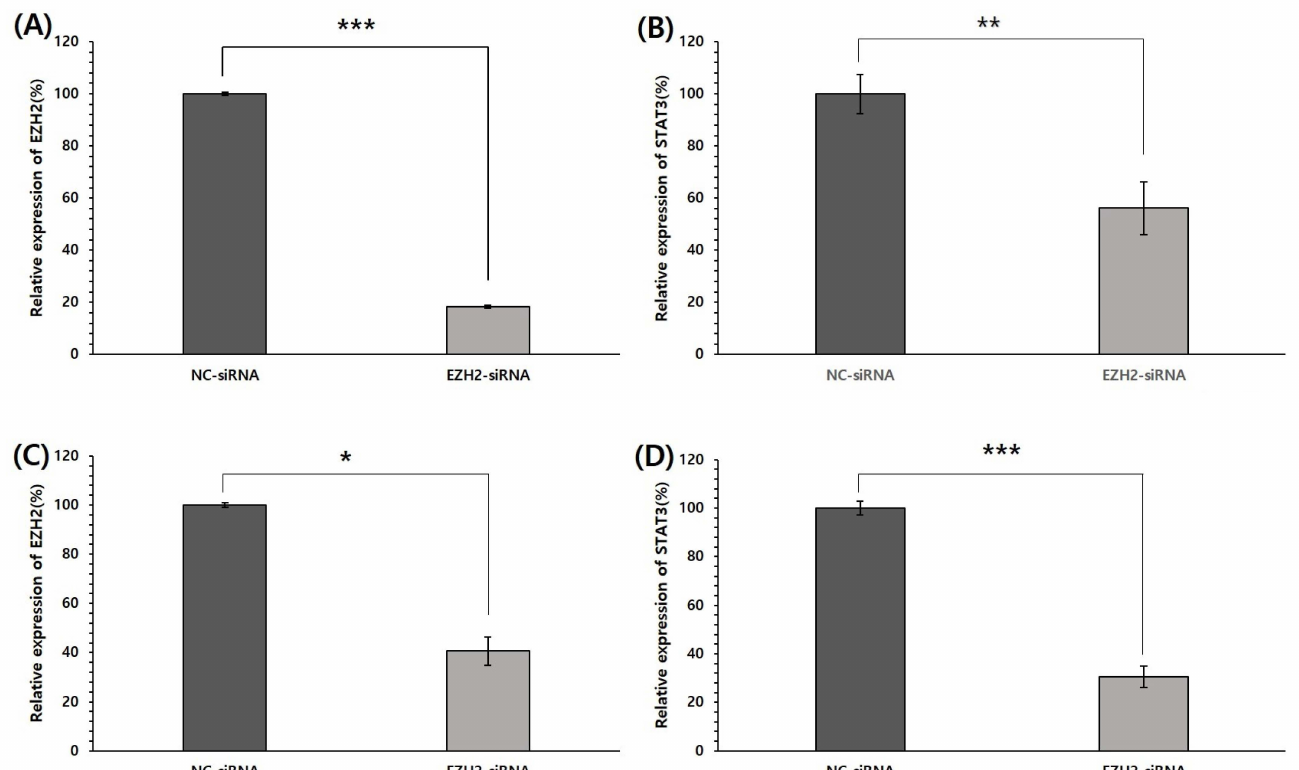
Figure 3. siRNA knockdown of EZH2 in HCC cells and the association between EZH2 and STAT3 mRNA expression. ( A ) Detection of EZH2 mRNA expression in HepG2 cells at 48 h after transfection. ( B ) After EZH2 knockdown, STAT3 mRNA expression in HepG2. ( C ) Detection of EZH2 mRNA expression in Huh1 cells at 48 h after transfection. ( D ) After EZH2 knockdown, STAT3 mRNA expression in Huh1. * p < 0.05, ** p < 0.01, and *** p < 0.001 by Student’s t